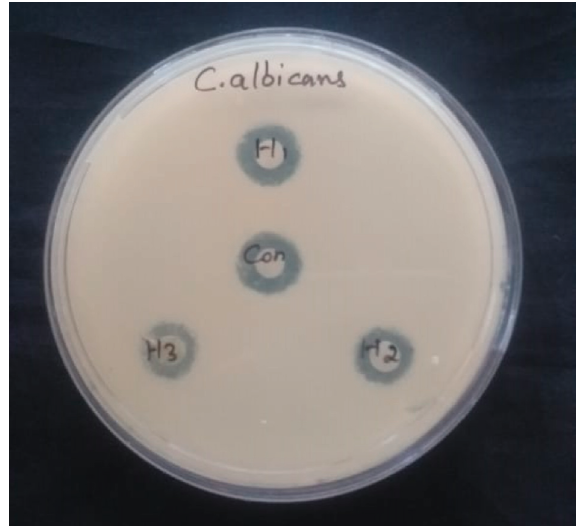
Figure 14: Antifungal activity of Ag-NPs.